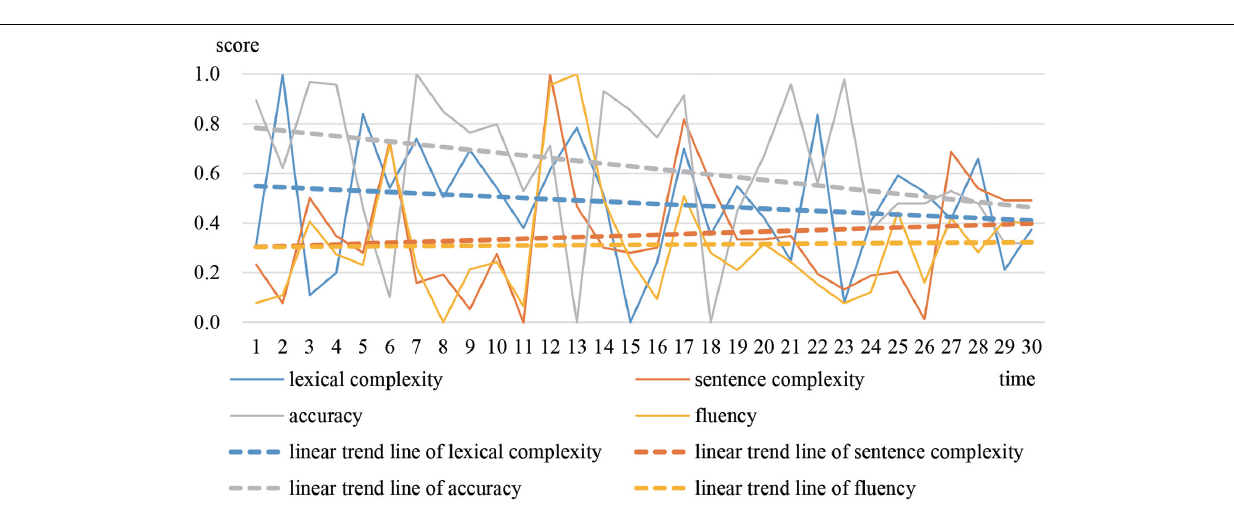
FIGURE 6 | Developmental trajectories and trends of Adam’s